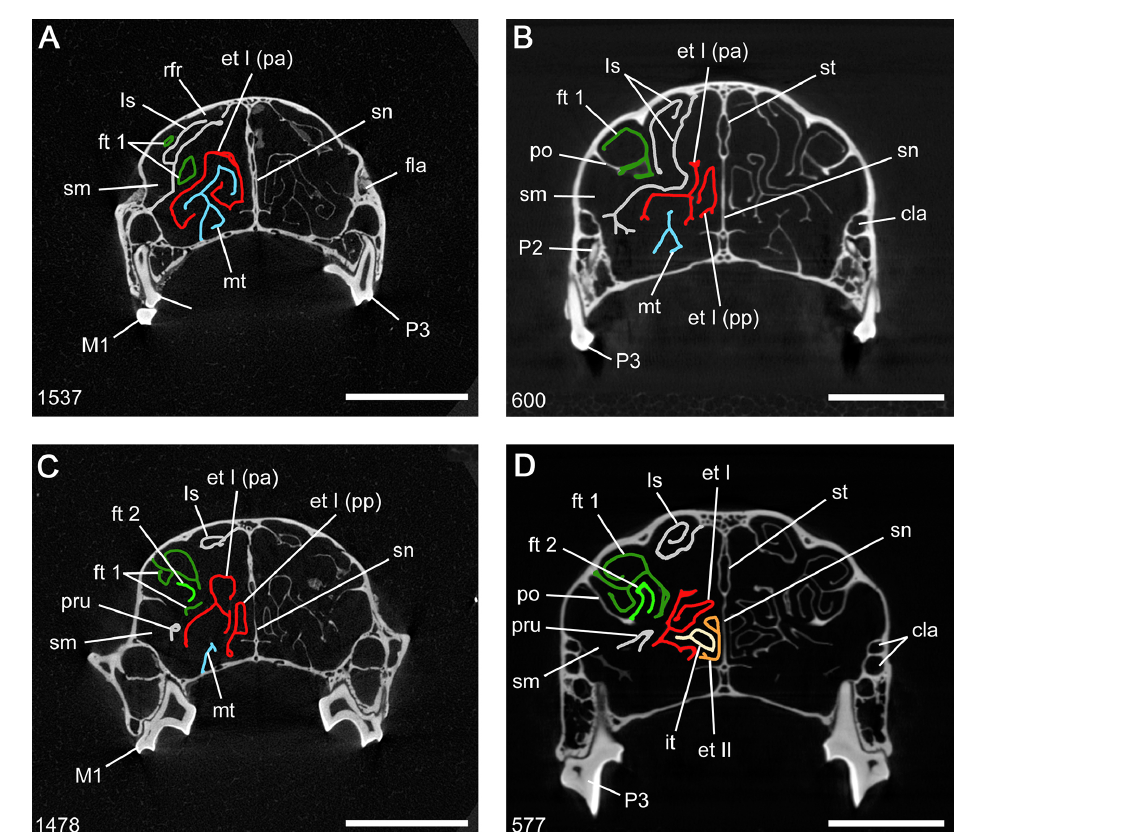
Figure 8. µCT cross-section images of the pars lateralis and posterior of the adult rostrum from anterior to posterior of (a , c) Ptilocercus lowii (ZMB 3992) and (b , d) Tupaia sp. (collection W. Maier). Numbers in figures refer to number of original µCT slices. Abbreviations: cla, canaliculus lacrimalis; et I, II, ethmoturbinal I, II; fla, foramen lacrimale; ft 1, 2, frontoturbinal 1, 2; it, interturbinal; ls, lamina semicircularis; M1, upper molar 1; mt, maxilloturbinal; P2, 3, upper premolar 2, 3; pa, pars anterior; po, pars obtecta (paries conchalis); pp, pars posterior; pru, processus uncinatus; rfr, recessus frontalis; sm, sinus maxillaris; sn, septum nasi; st, septoturbinal. Scale bars equal 2mm.